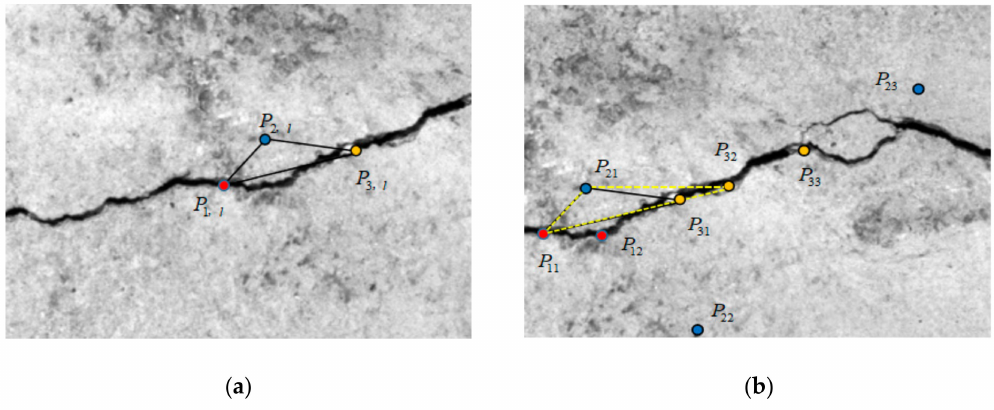
Figure 11. Schematic diagram of feature point correlation matching: ( a ) left figure and ( b ) right figure.